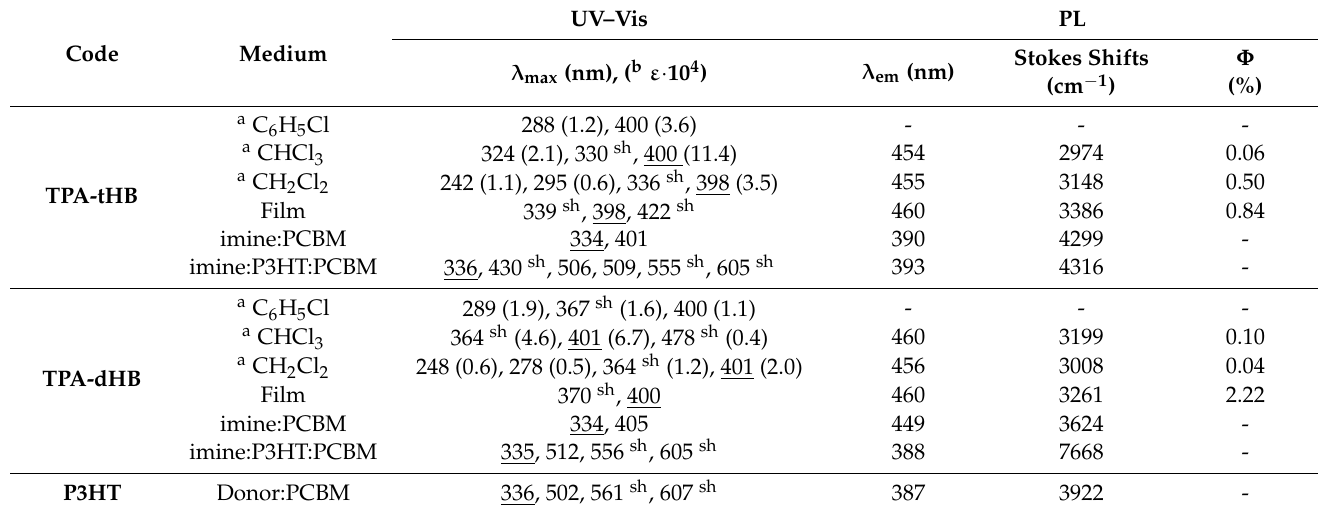
( b ) Figure 4. UV – Vis ( a ) and PL ( b ) spectra of imines in blend together with spectra of P3HT and P3HT:PCBM.